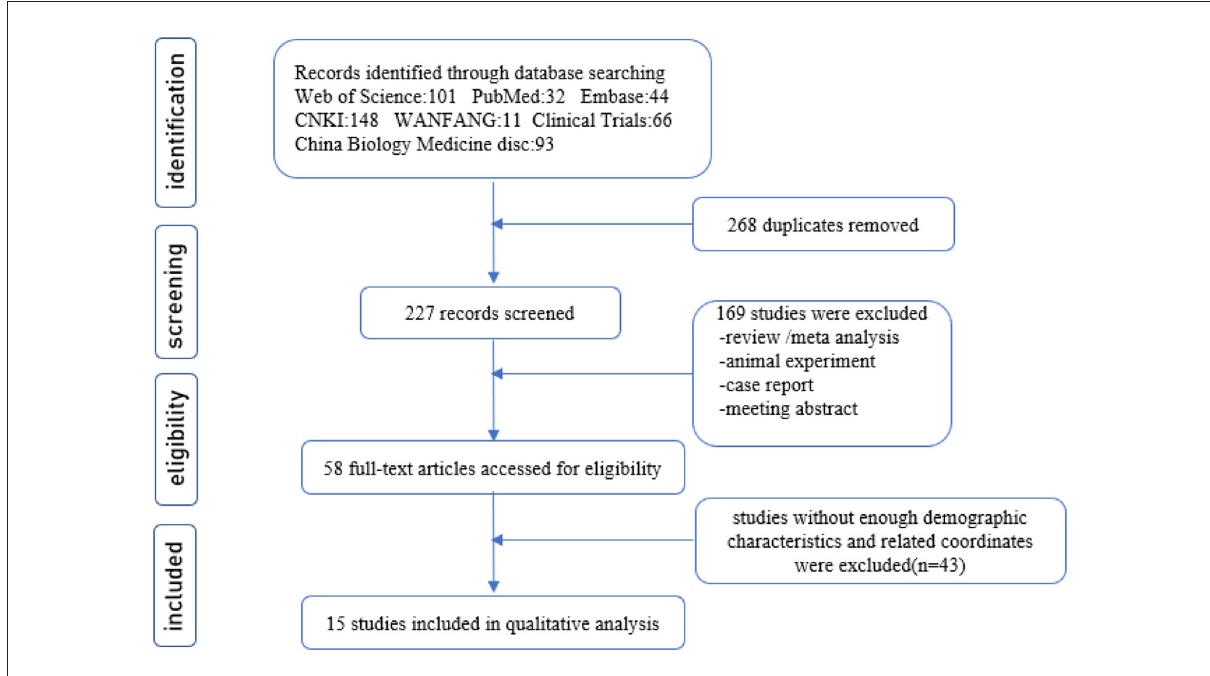
FIGURE1 Flowchart shows the study selection